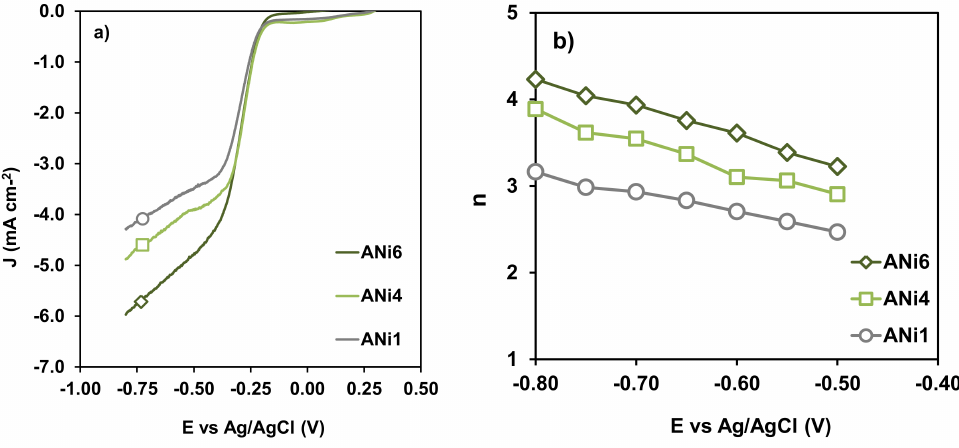
Figure 10. ( a ) LSV curves at 2500 rpm, and ( b ) variation of n with E vs. Ag/AgCl for samples ANi1 (